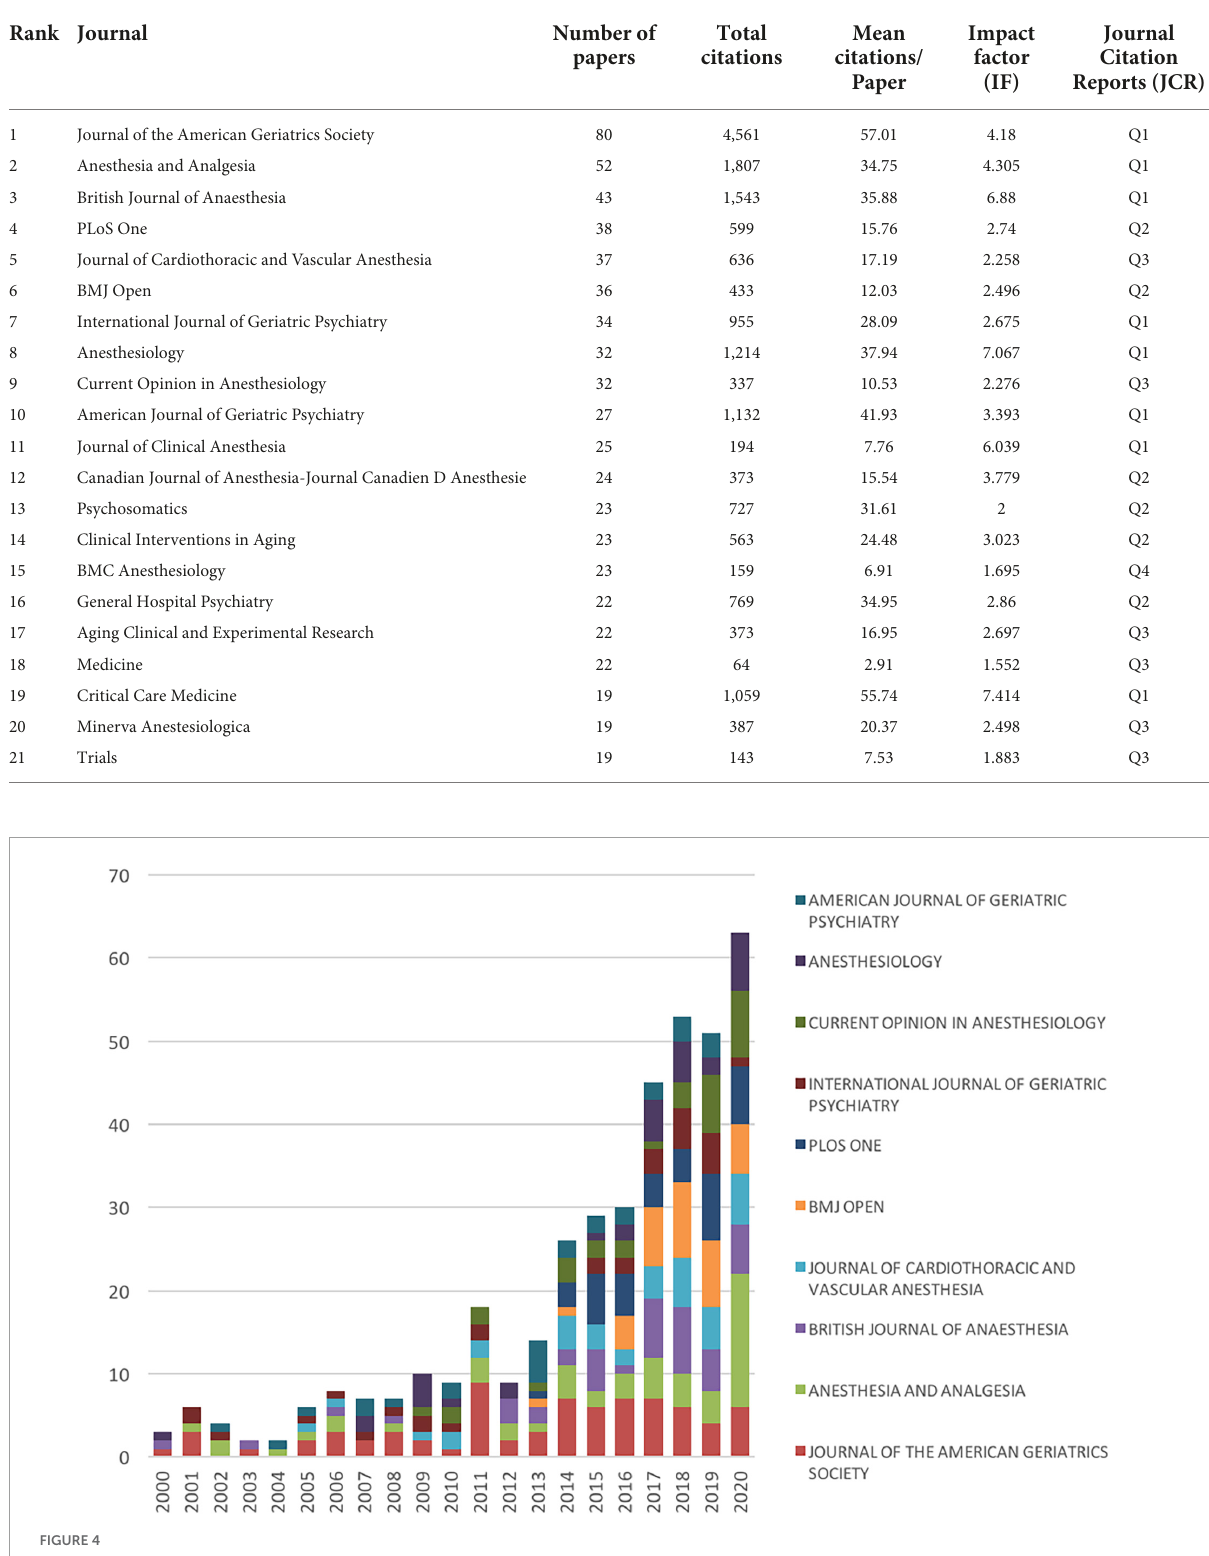
TABLE 4 The top 20 journals with the highest number of publications on postoperative delirium (POD).